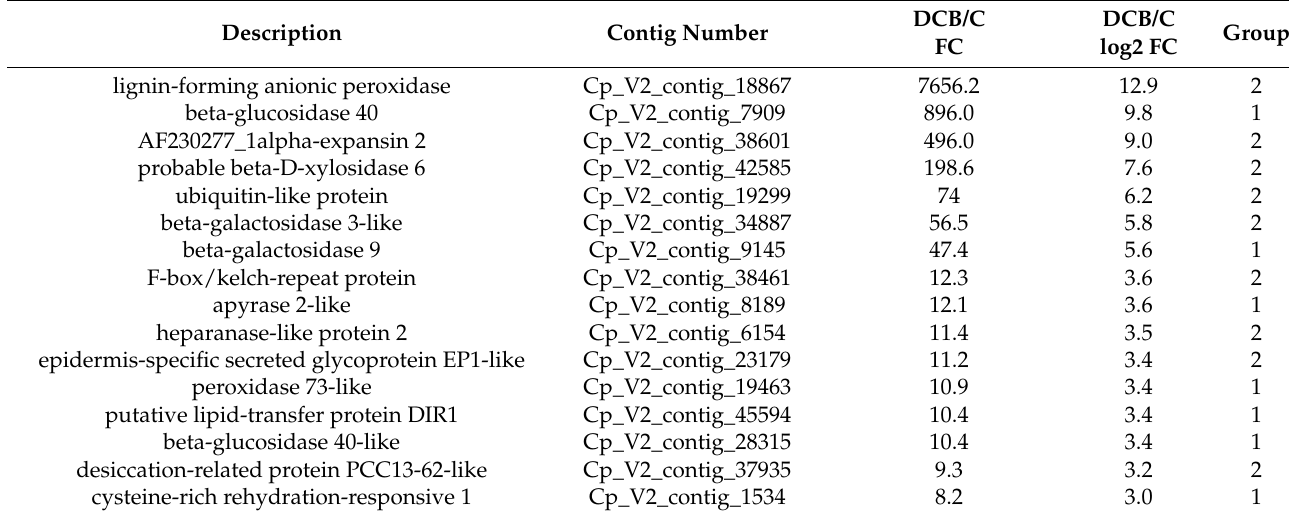
Table 1. Excerpt of Supplementary File S1 showing proteins with higher abundance in DCB-habituated cells compared to the control (C). The fold change (FC ≥ 8) and log2 FC ≥ 3, as well as the contig numbers, group classification according to the HC are